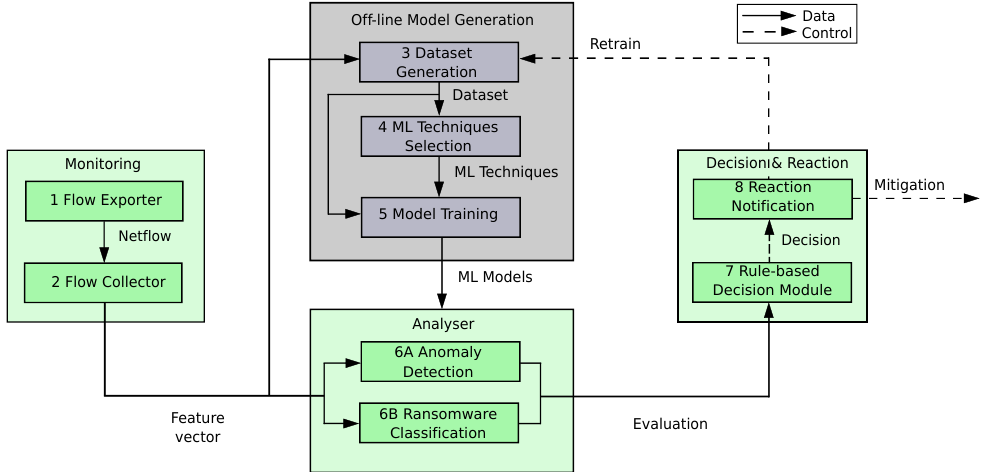
Figure 2. Design of the proposed solution to detect, classify and mitigate ransomware in